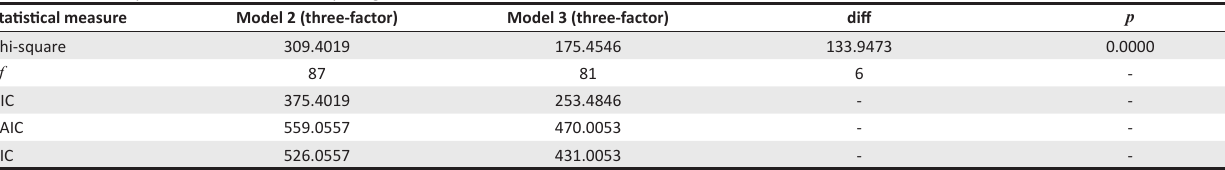
TABLE 2b: Summary statistics of the two competing models – Model 2 and Model 3. Statistical measure